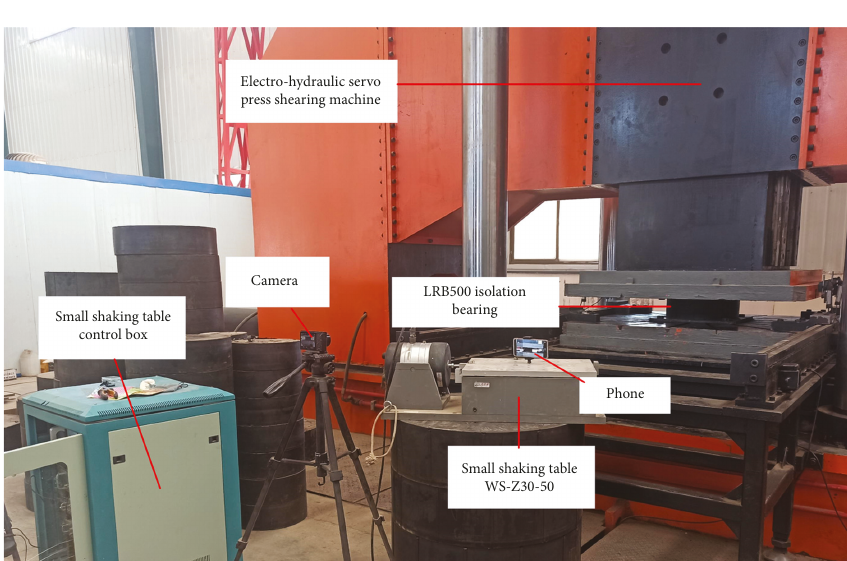
Figure 7: Test site layout.